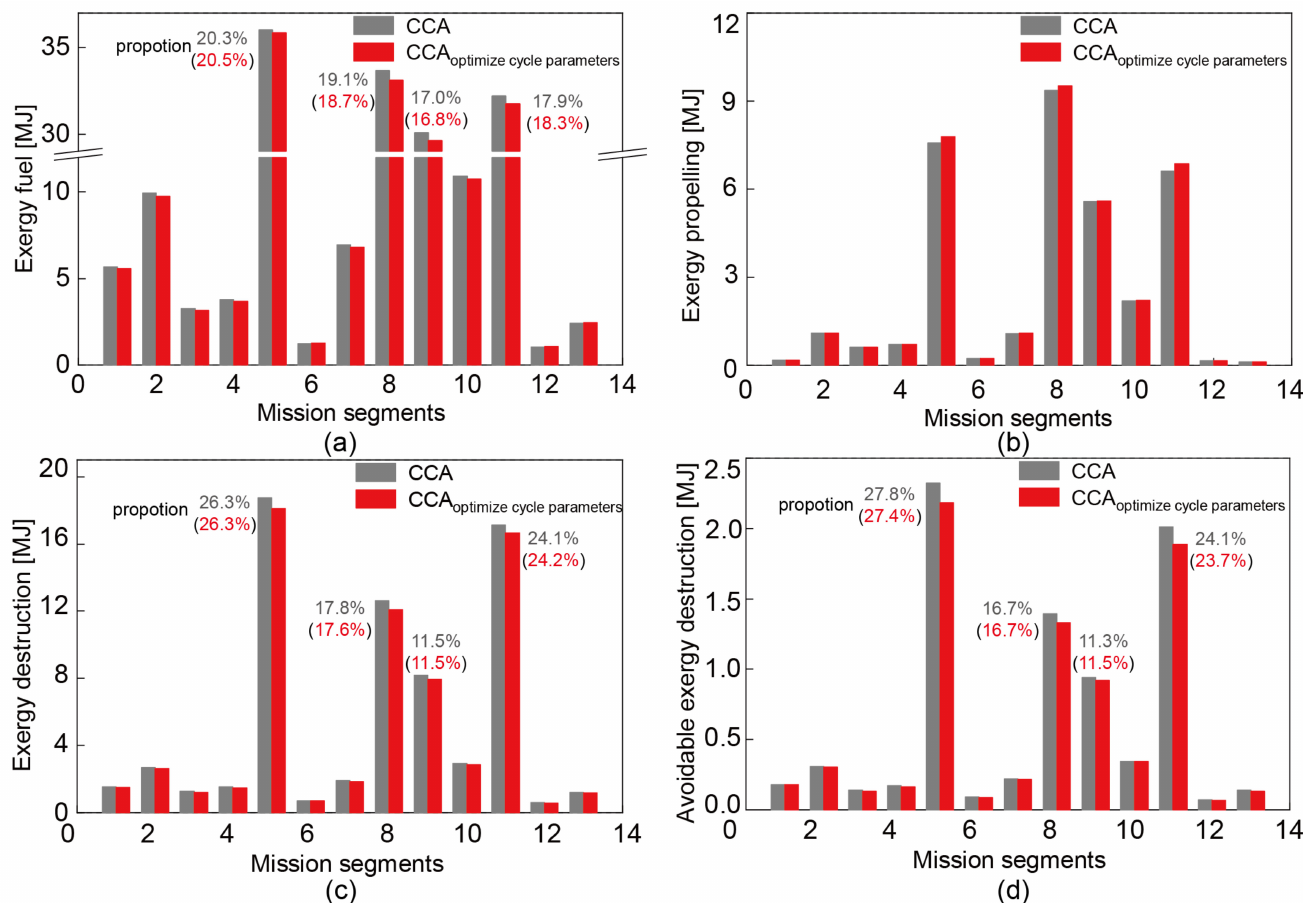
Figure 13. The comparison of exergy indicators between different schemes under full flight